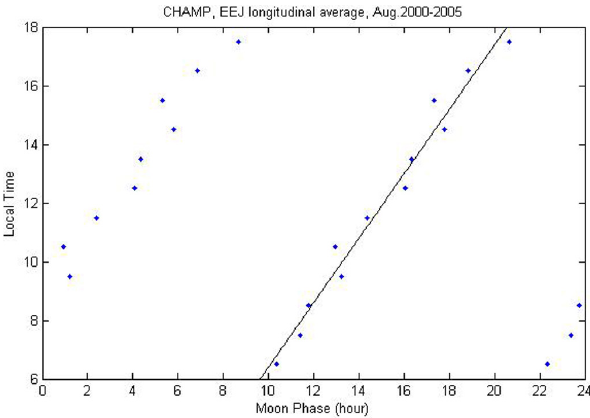
Fig. 3. Phase propagation of the semi-monthly lunar tide as a func- tion of moon phase. Dots mark for each local time hour the moon phase when the tidal wave crest is